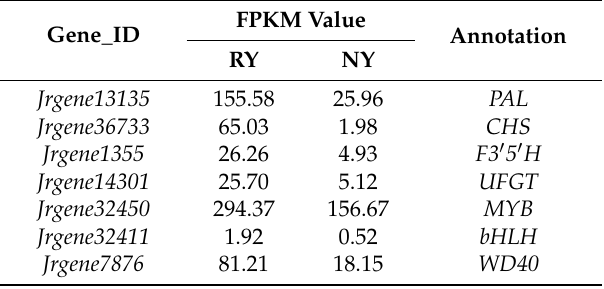
Table 4. Expression profiles of anthocyanin biosynthesis genes in the leaf of